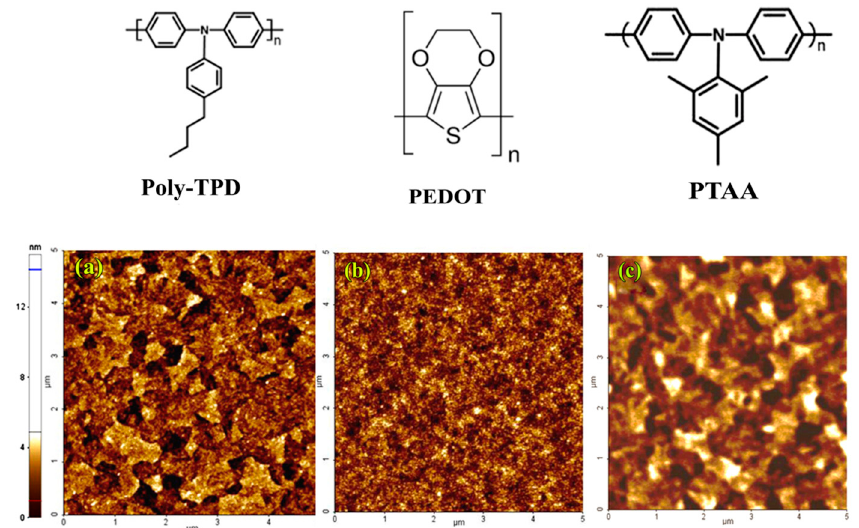
Figure 2. AFM images (5 × 5 μ m) of Poly-TPD (Rq = 1.72 nm) ( a ), PEDOT (Rq = 3.10 nm) ( b ), and PTAA (Rq = 1.01 nm) ( c ).